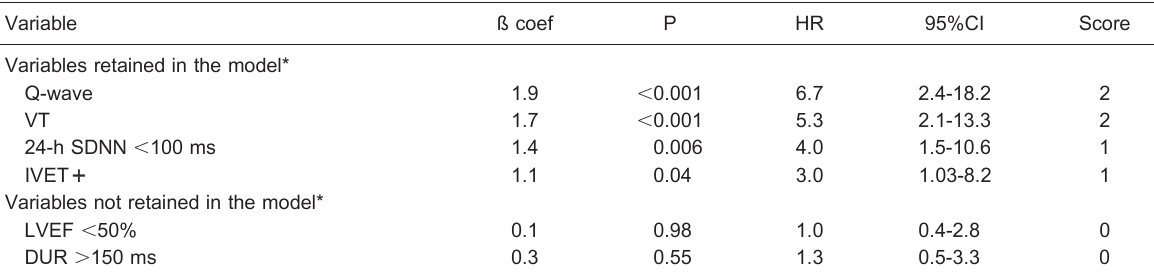
Variables not retained in the model* LVEF , 50%